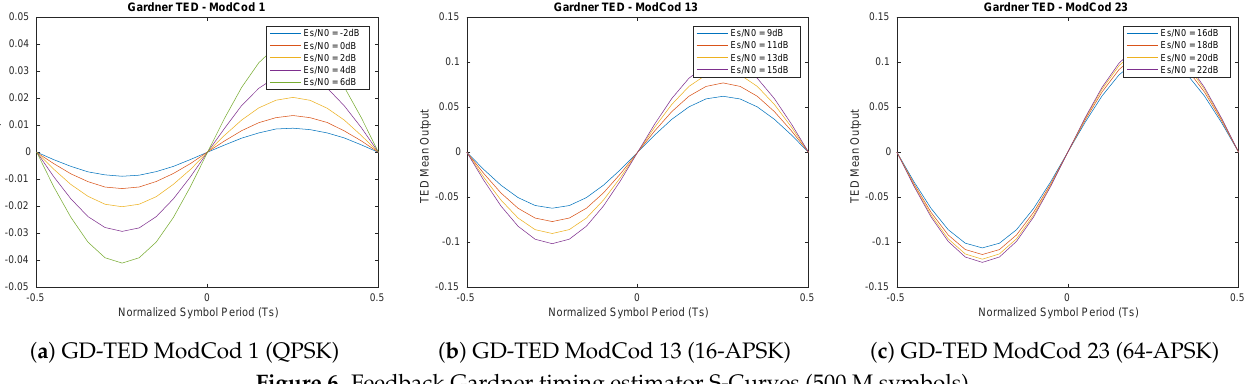
Figure 6. Feedback Gardner timing estimator S-Curves (500 M symbols).